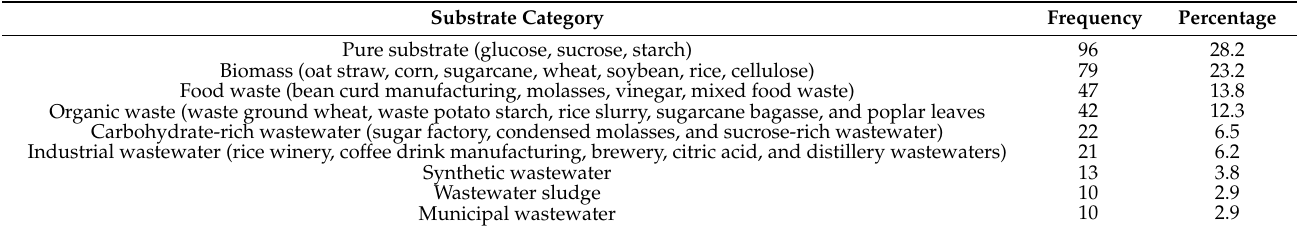
Table 2. Frequency and percentage of substrate types, grouped by